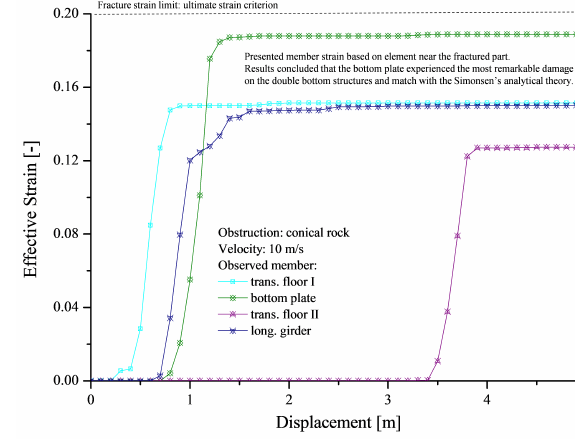
Figure 11: Strain level compared to the selected ultimate strain limit in grounding